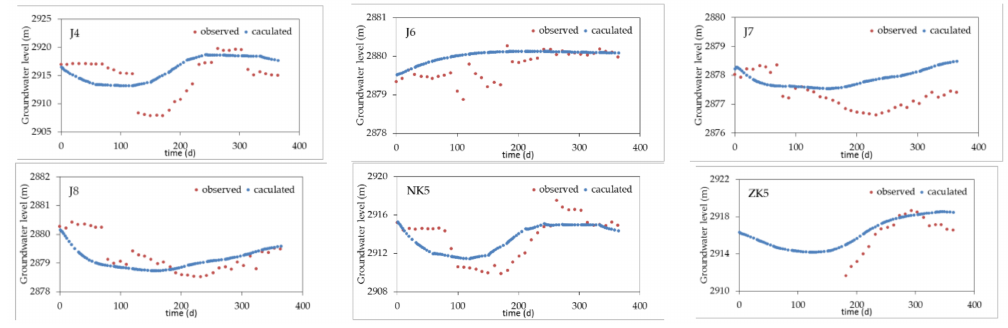
Figure 9. Curves fitted to groundwater observation wells in the calibration period.